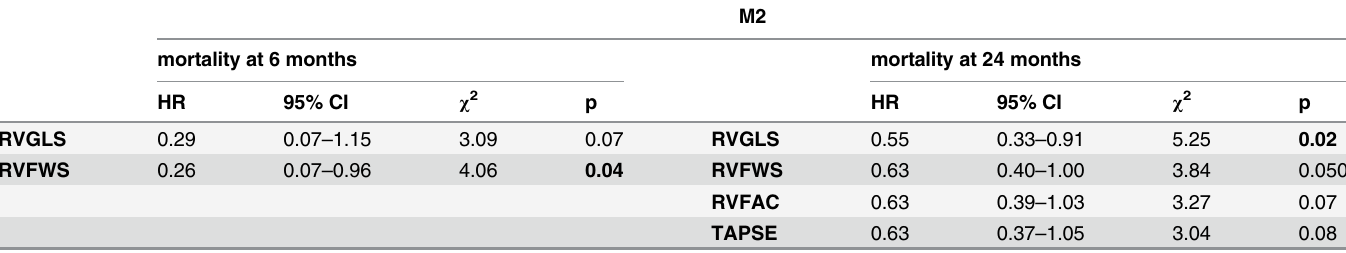
Table 5. Multivariable Cox regression analysis of right ventricular functional parameters predicting mortality at 6 and 24 months. Model 2 (M2): covariates were selected based on current CRT guidelines.